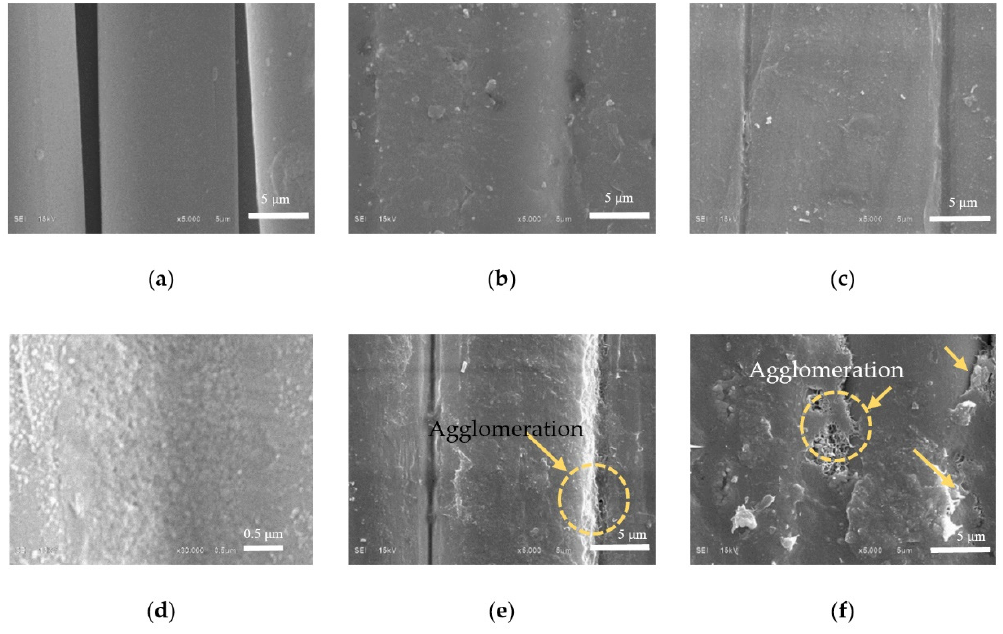
Figure 4. Surface images of ( a ) pristine aramid fabric and poly(BA-a-co-PU) 80/20 reinforced by aramid fabric and various MWCNT content ( b ) at 0.0 wt% ( c ) 0.25 wt% ( d ) 0.25 wt% ( e ) 0.5 wt%, and ( f ) 2.0 wt%.